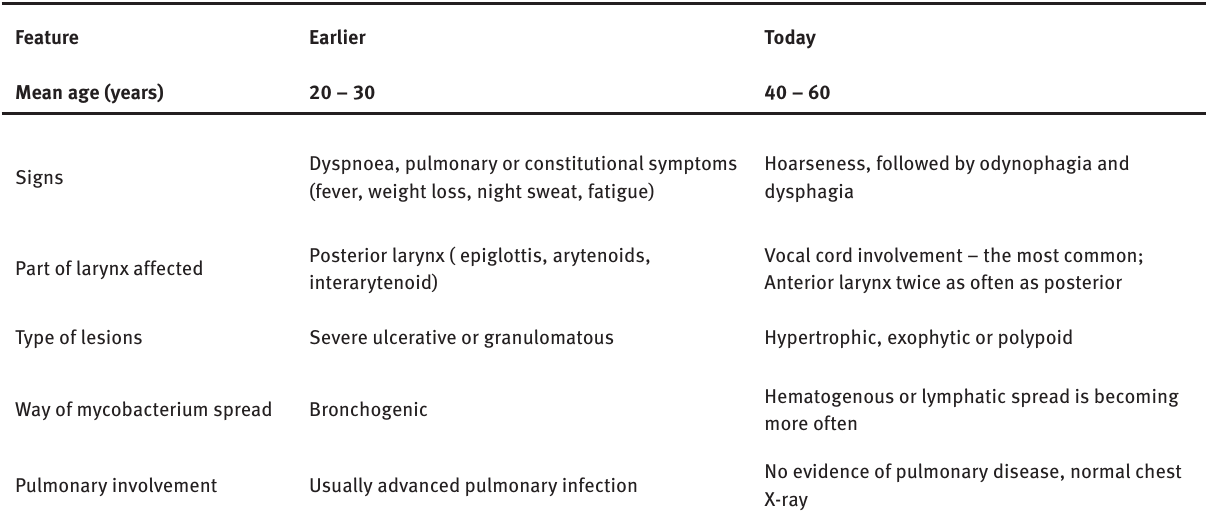
Table 1: Changes in clinical pattern of laryngeal tuberculosis